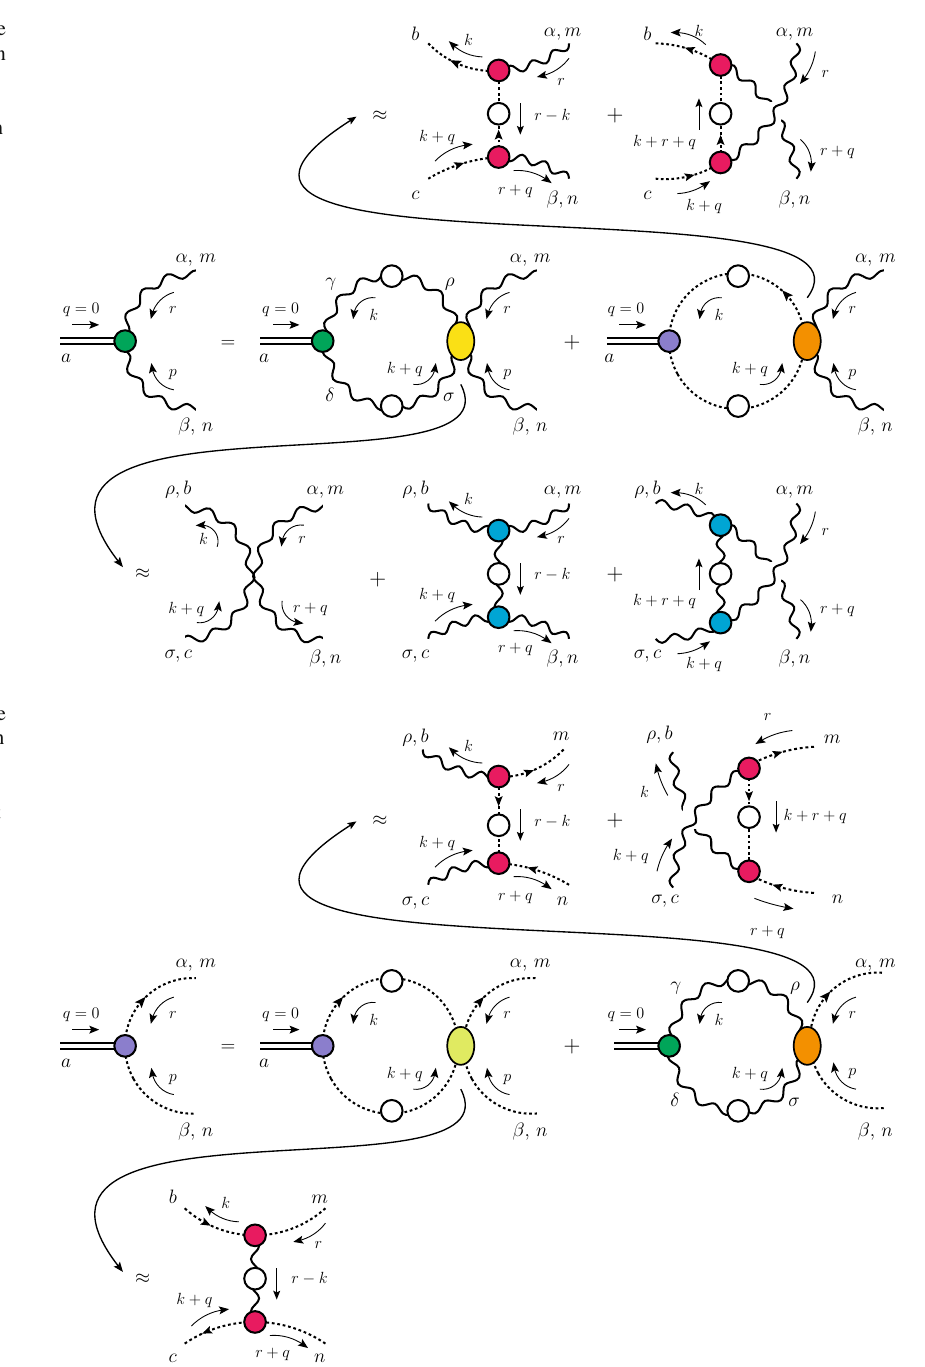
Fig. 4 The BSE satisfied by the gluon bound-state wave function (cid:2) C αβ (center) in the presence of both gluon and ghost massless poles. The simplified four-gluon and gluon-ghost kernels used are also shown